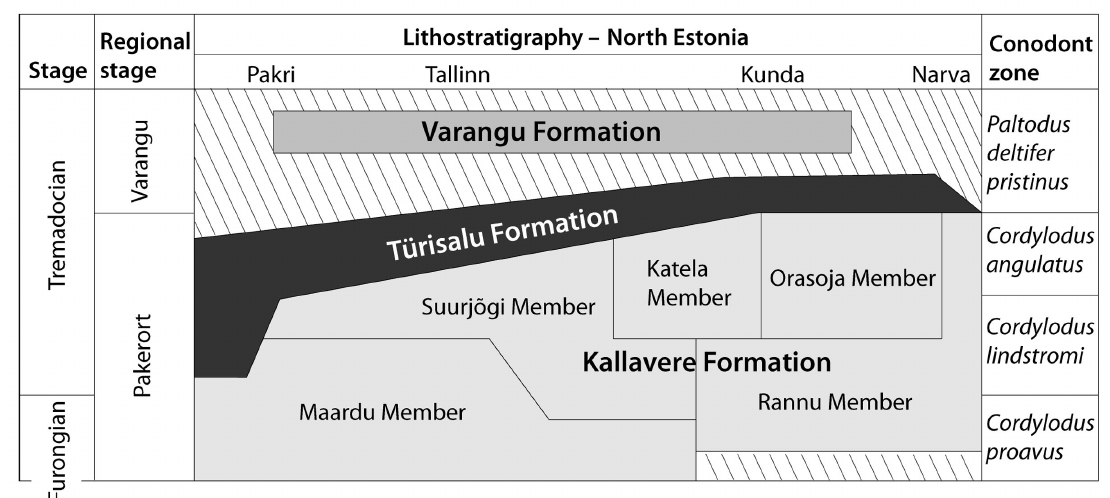
Fig. 1. Stratigraphic position of the T(cid:252)risalu Fm. (modified after Heinsalu et al.